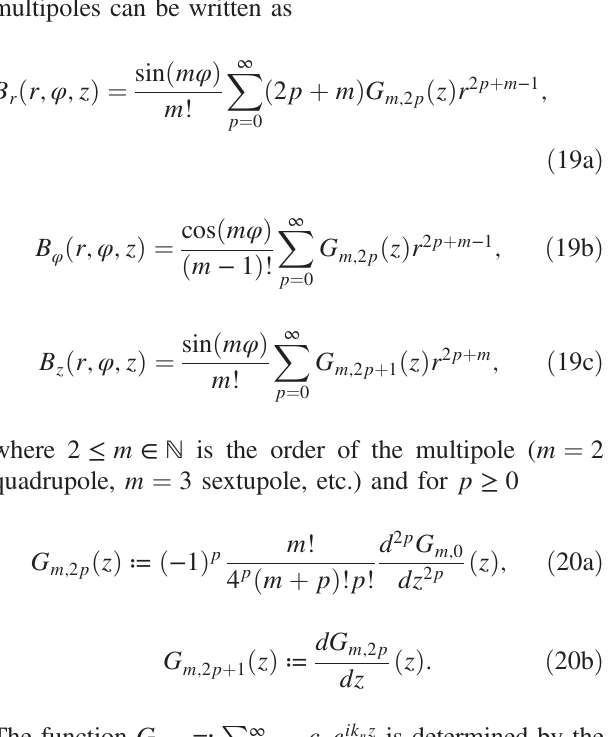
FIG. 1. Enlarged part of the Fourier decomposition of the z Þ − z with K ¼ 25 (red curve), 15 (blue curve), and function T K ð 5 (magenta curve) Fourier coefficients. The function is expanded over the same interval where the Fourier decomposition of the reference field from RADIA is done (Sec. IV). The integration is conducted from one zero crossing to another one, where the zero crossings are determined with the Newton method. The integration interval starts at z 0 , z 0 , and z 0 depending ; 25 ; 15 ; 5 upon the number of Fourier coefficients utilized (25, 15, and 5,